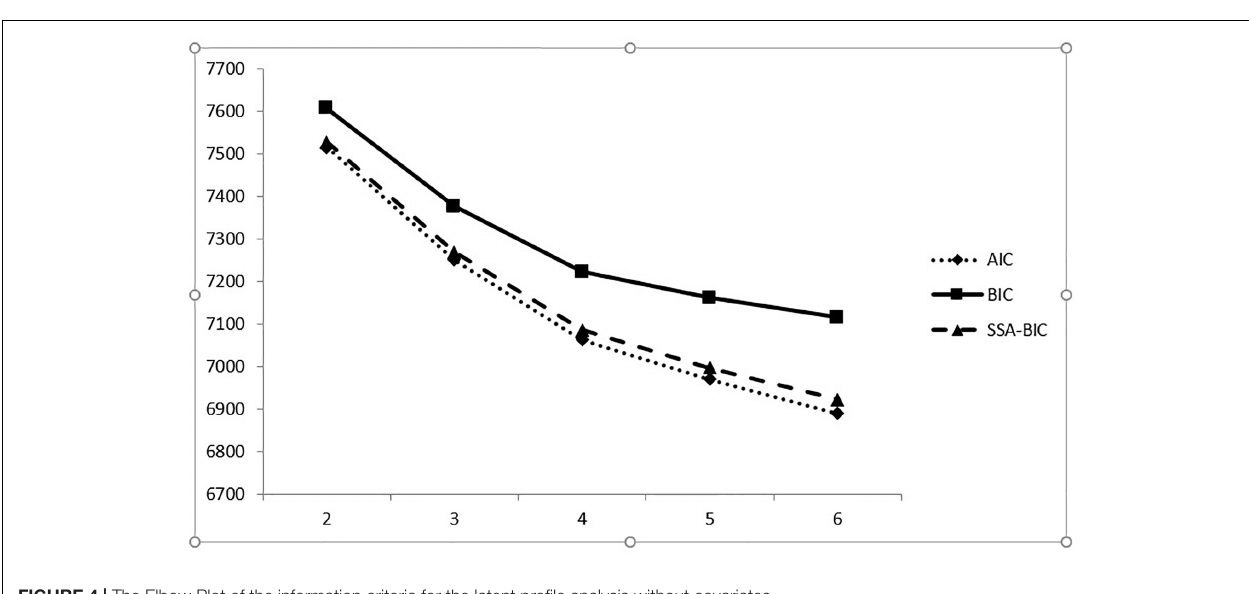
FIGURE 4 | The Elbow Plot of the information criteria for the latent profile analysis without covariates. TABLE 9 | Model fit indices for two- to six-class solutions of Chinese Organizational Identification without